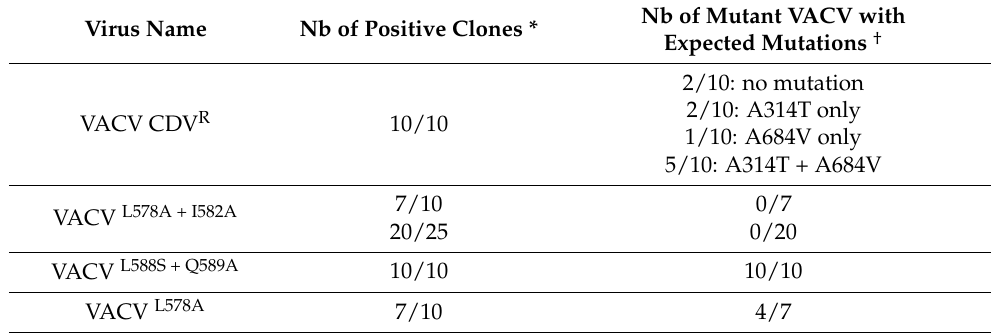
Table 3. Analysis of mutant VACV.